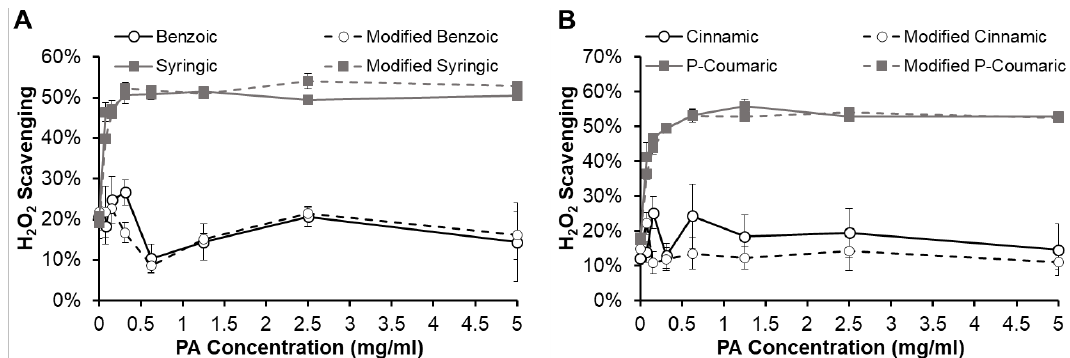
Figure 7. Antioxidant properties of modified phenolic acids in comparison to their unmodified controls as quantified by hydrogen peroxide scavenging capabilities from the ( A ) benzoic acid group and ( B ) cinnamic acid group. n = 3, mean ± standard deviation displayed.